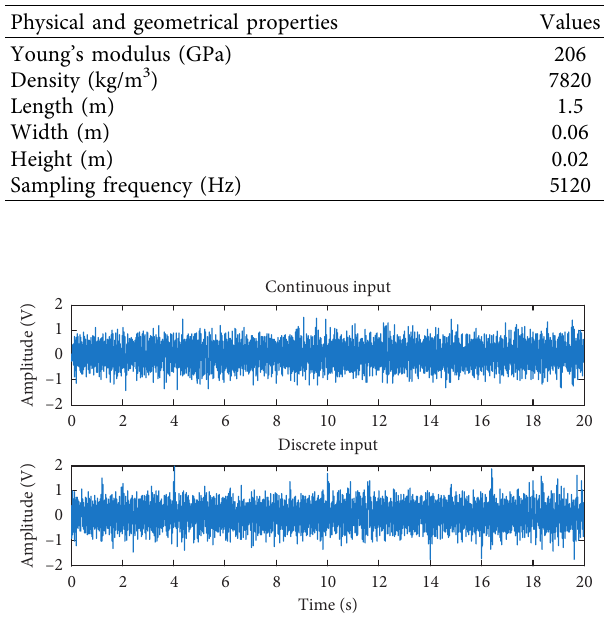
Figure 7: Continuous input voltage and discrete input voltage.